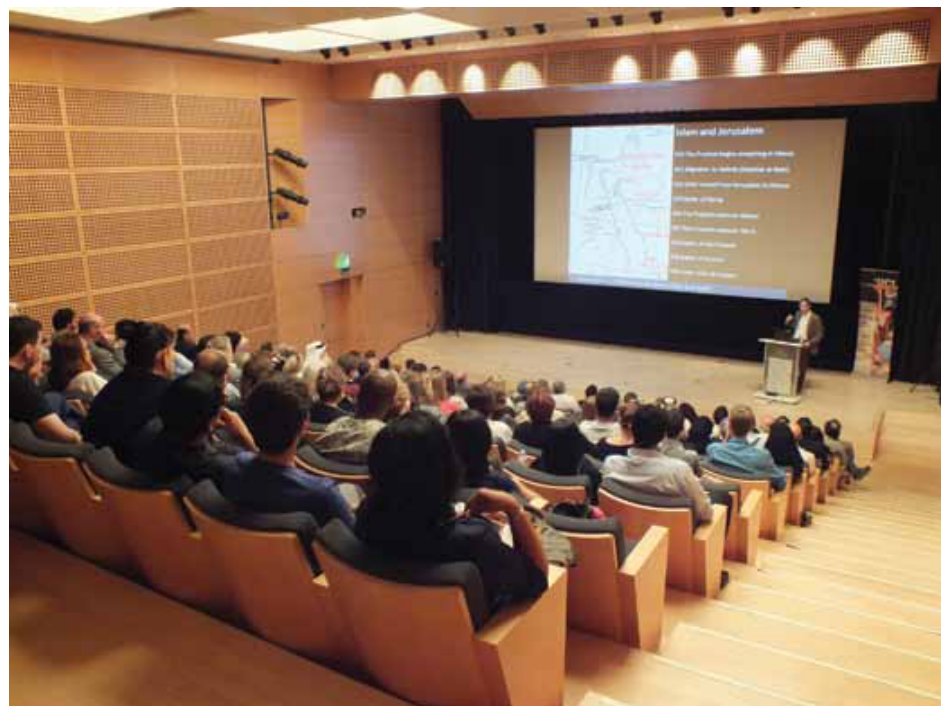
Fig. 2: The UCL Qatar inaugural public lecture by Tim